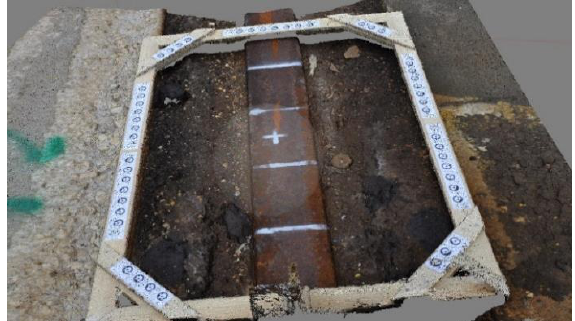
Figure 8. Point cloud performed by Agisoft PhotoScan